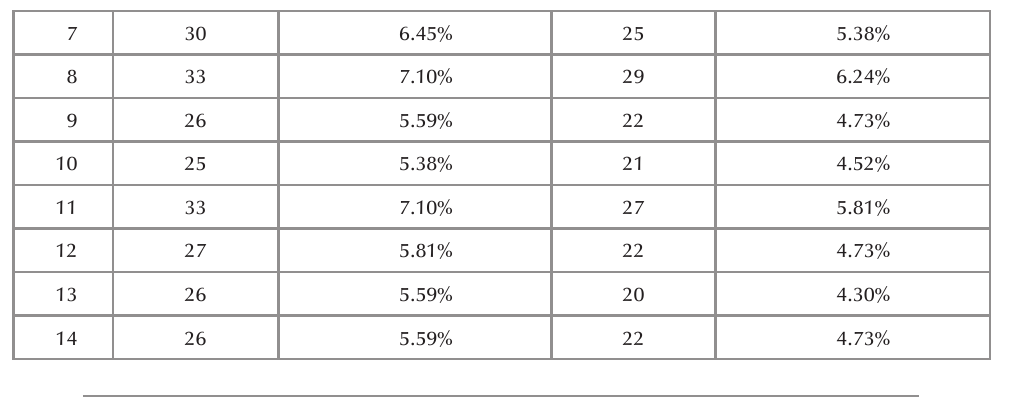
and LVaR techniques clearly simple JS